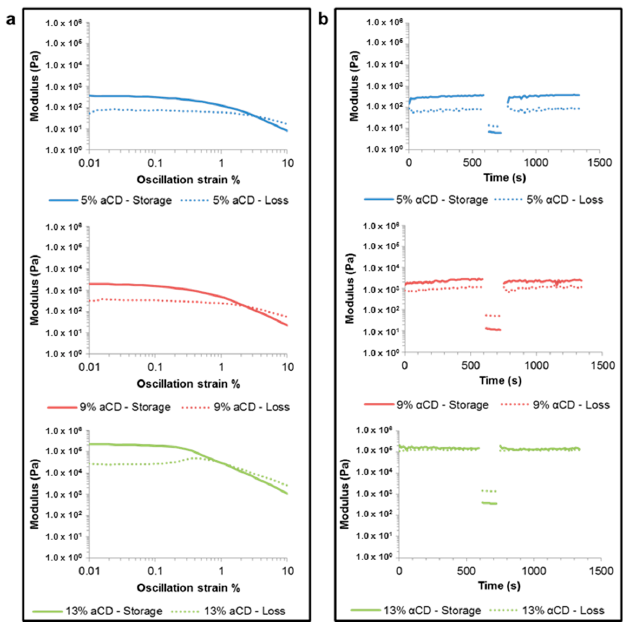
Figure 4. Rheology performed on hydrogels formed with 2% PGS-PEGMEMA 2 and varying concentrations of α CD: 5% ( top ), 9% ( middle ) and 13% ( bottom ). The moduli of the hydrogels increased as the concentration of α CD increased. ( a ) As the oscillation strain % increased from 0.01% to 10%, the hydrogel changed from a gel ( G ’ > G ”) to a liquid ( G ’ < G ”). This demonstrated that the shear strain; ( b ) The strain % was alternated between 0.01% and 10% and back to 0.01%. The